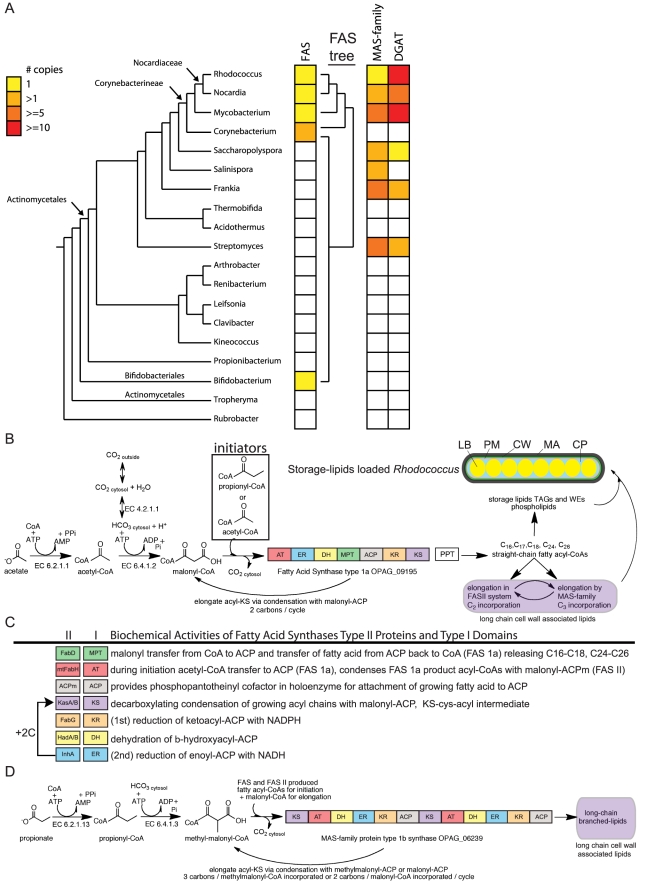
Phylogenetic and metabolic pathway features of lipid biosynthesis in Rhodococcus.a) A phylogenetic representation of oleaginous genes in Actinomycetales. An AMPHORA-based tree of related genera (left) provides context to the copy number of unique oleaginous genes within each genera presented in three columns to the right. Remarkable oleaginous genes in Actinobacteria are fatty acid synthase (FAS) type 1a, MAS-family type 1b, and diacylglycerol acyl-transferases (DGATs). Oleaginous gene family members in each genus were counted and color-coded from 0 to >10. A phylogenetic tree of the FAS type 1a gene is presented to the right of the FAS column. b) Fatty acids biosynthesis in Rhodococcus. Acetyl-CoA is the product of many biochemical reactions and a limiting substrate in lipid biosynthesis. Acetyl-CoA can also be generated from acetic acid found in the environment by ligation to –CoA. ATP-hydrolysis enables bicarbonate coupling to acetyl-CoA forming malonyl-CoA, the substrate used for elongation. The lipid biosynthesis -CoA substrates are incorporated in Rhodococcus by three fatty acid biosynthesis systems that begins with multifunctional FAS type 1a. This synthase contains the following enzyme activities: malonyl palmityl transferase (MPT), acetyl transferase (AT), keto synthase (KS), keto reductase (KR), dehydratase (DH), enoyl reductase (ER), acyl carrier protein (ACP) catalyzing decarboxylating condensation of malonyl-ACP with acetyl-CoA, propionoyl-CoA, or acyl-CoAs to generate straight-chain fatty acyl-CoAs that range in size (C16–C26) and include odd-carbon fatty acids. Phosphopantotheinyl transferase (PPT) converts the ACP domain of FAS into the active form via attachment of phosphopantotheinate to a serine residue and is encoded by the down stream gene in the Rhodococcus bicistronic FAS operon. During inititiation malonyl-ACP is condensed with either acetyl-CoA or propionoyl-CoA to form a C4 or C5 straight-chain intermediate, respectively. Further elongation cycles consume malonyl-ACP for C2 additions with concomitant release of CO2 for each round of Claisen-type condensation reaction. The fatty acyl-CoA products of FAS <C20 are attached to glycerol catalyzing production of phospholipids and triacylglycerols (TAGs) or processed by number of other routes. Fatty acyl-CoAs can be further elongated by the FAS II system or MAS-family proteins. Wax esters (WEs) are generated by transesterification of fatty acyl-CoAs with fatty alcohols. TAGs, WEs, phospholipds, FAS II and MAS products come together to form compartments within Rhodococcus. Lipid bodies (yellow, LB) house the stored lipids surrounded by cytoplasm (blue, CP). The Plasma Membrane (orange, PM) is surrounded by cell wall (green, CW). The mycolic acid layer (black, MA) on the outside of Rhodococcus cells contains the long chain lipids. 1c) Comparison of biochemical activities of type II proteins and type I protein domains. Colors of FAS II genes correspond to related function in type 1 protein domains. Notable differences between synthase type 1 domains and type 2 proteins include: the MPT domain is dual functional in FAS type 1a thus releasing –CoA products through palmitoyl-CoA activity. The AT domain in type 1a provides acetyl-CoA and propionoyl-CoA substrates for condensation. In type 1b synthase the AT domain provides long chain acyl-CoAs for condensation on the KS domains. 1d) Methyl-branched lipid biosynthesis model for type 1b synthase activity from related mycobacterial protein PKS12. The C3 organic salt propionate can be ligated to CoA generating propionoyl-CoA, a substrate for Rhodococus lipid biosynthesis that is also produced in several metabolic degradation pathways. Propionoyl-CoA can be used directly by FAS during initiation or carboxylated to form methylmalonyl-CoA making it a substrate for a second multifunctional fatty acid synthase with a type 1b protein domain architecture present in Rhodococcus OPAG_06239. The type 1b synthase belongs to the mycocerosic acid synthase (MAS)-family of proteins that in Mycobacterium were shown to incorporate methylmalonyl-CoA into growing fatty acid chains creating methyl-branched lipids.